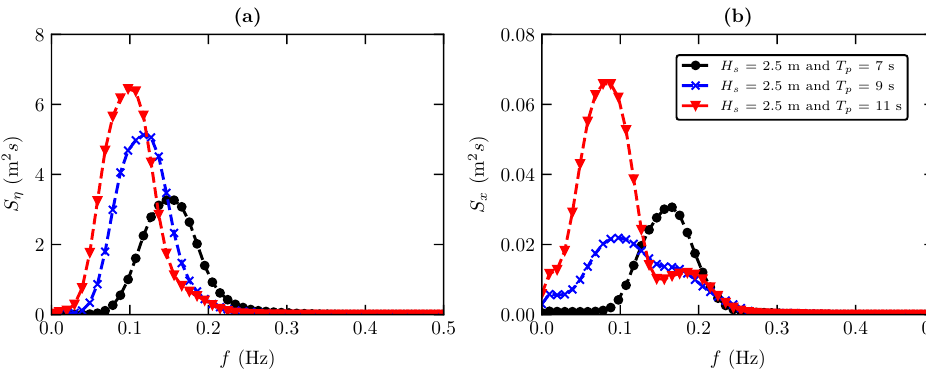
Figure 11. Power spectrum of ( a ) free-surface elevation measured at x = 220 m and of ( b ) horizontal position of hydraulic PTO system for H s = 2.5 m and T p = 7, 9 and 11 s.